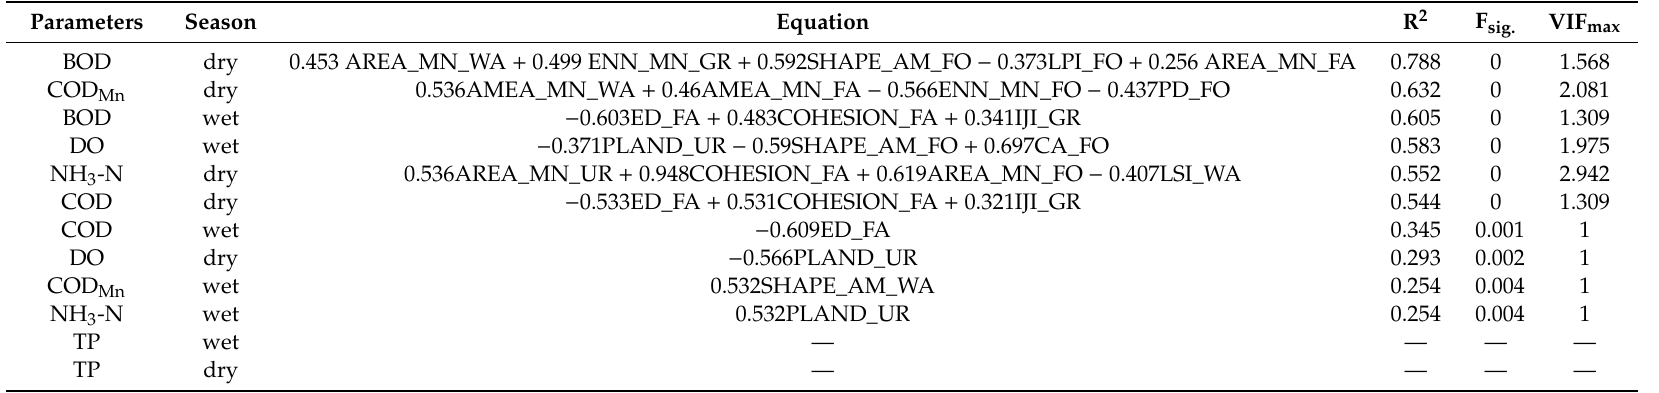
Table 7. Regression analysis of water quality parameters and landscape pattern